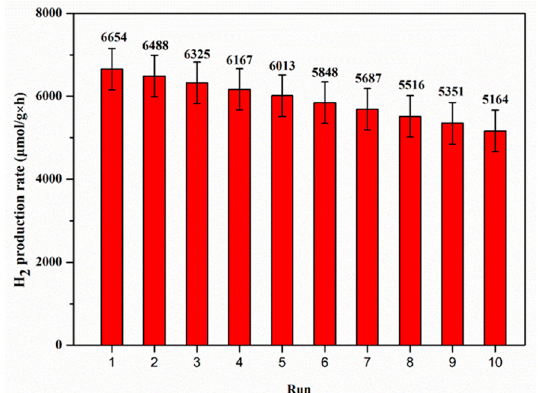
Figure 10. Hydrogen production efficiency of CuS/PbS/ZnO photocatalyst prepared at a hydrothermal temperature of 130 °C, under photocatalytic reaction with solar simulator irradiation for 5 h.